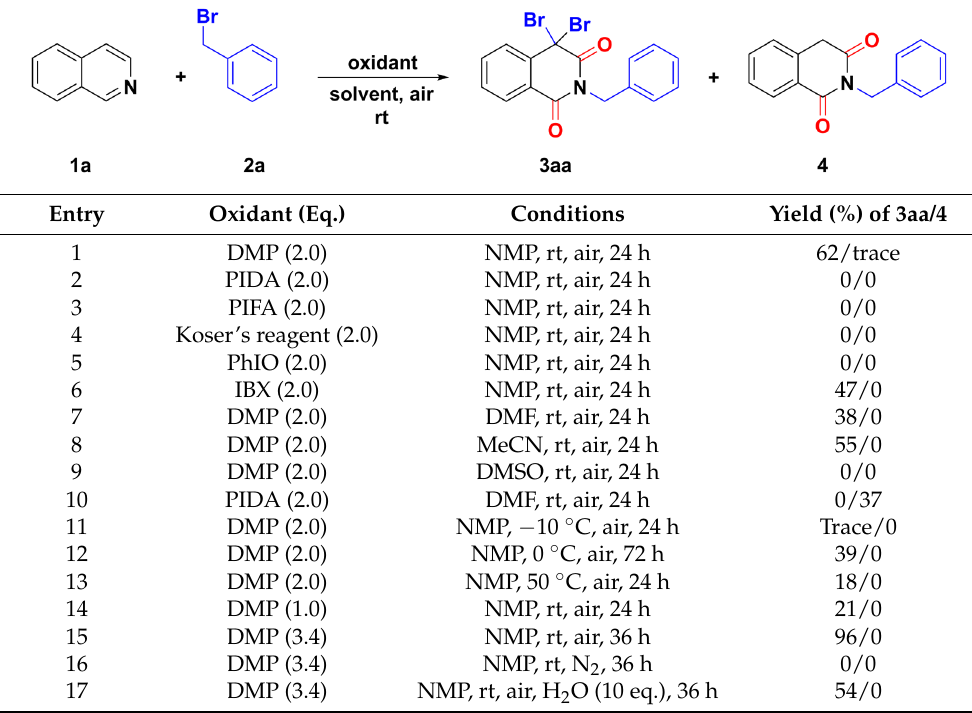
Table 1. Optimization of the reaction conditions a,b .